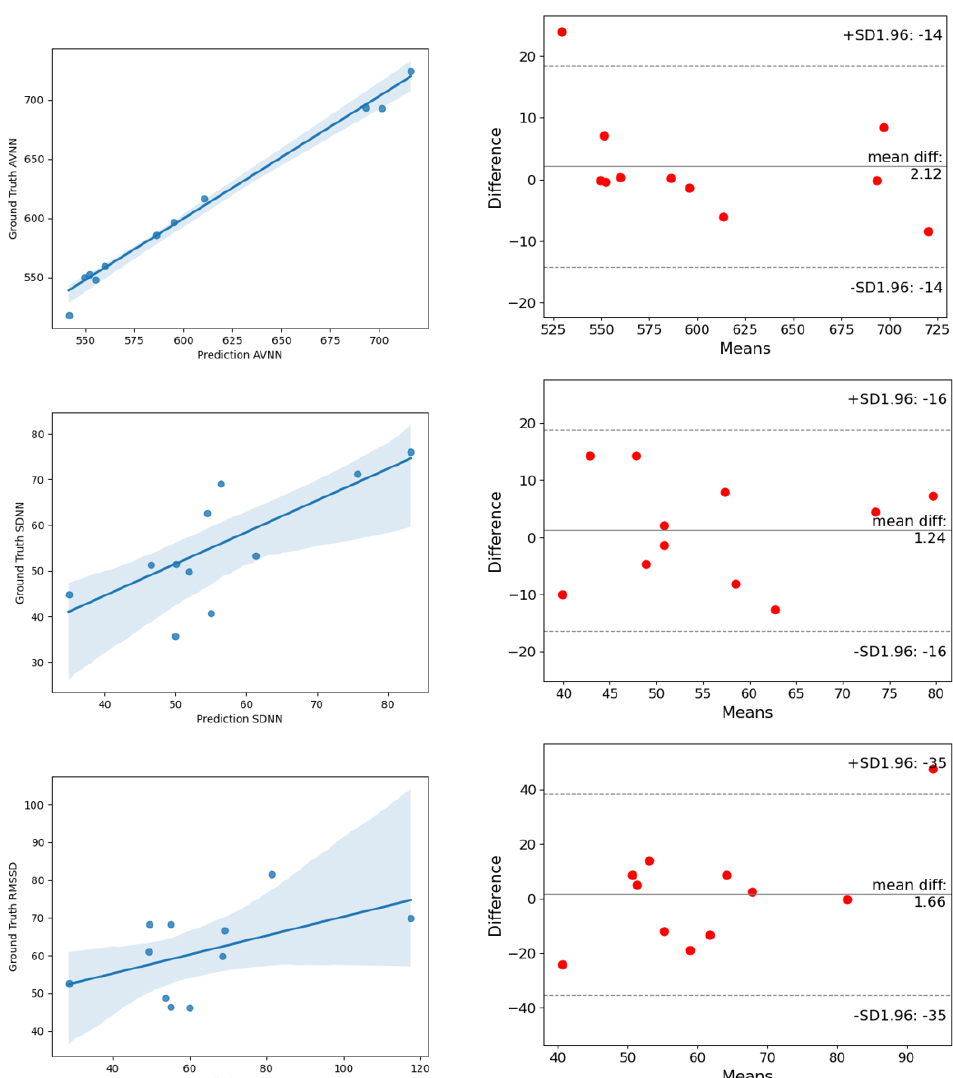
Figure 14. The analysis of the correlation plot ( left ) and the Bland–Altman plot ( right ) of time-domain metrics of HRV on the UBFC dataset. ( top ) is AVNN, ( middle ) is SDNN, ( bottom ) is